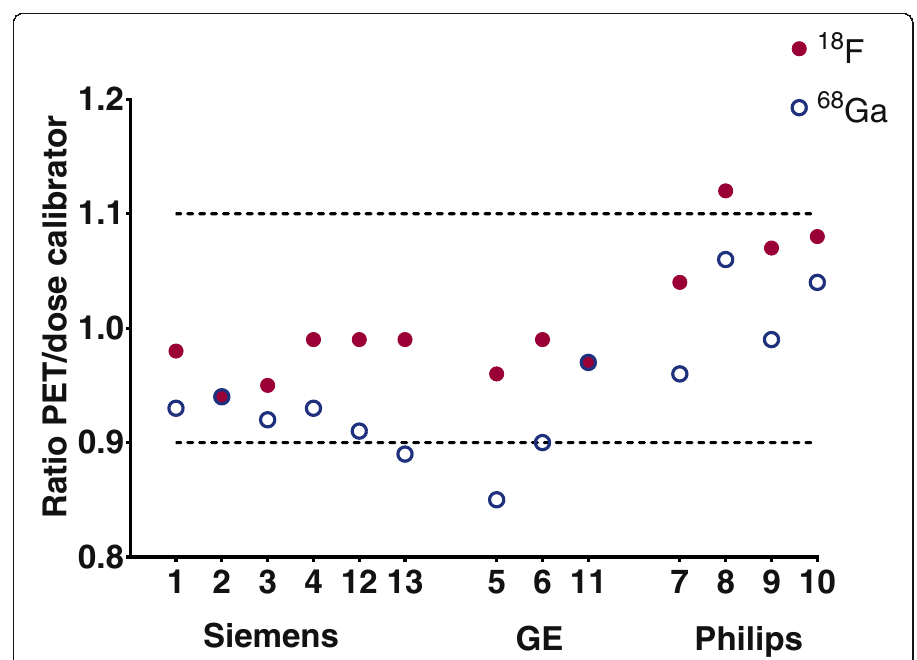
Fig. 1 Accuracy of the measured activity by the PET/CT system and local dose calibrator, based on the average between the cylindrical and IQ phantom. Numbers correspond to Table 2